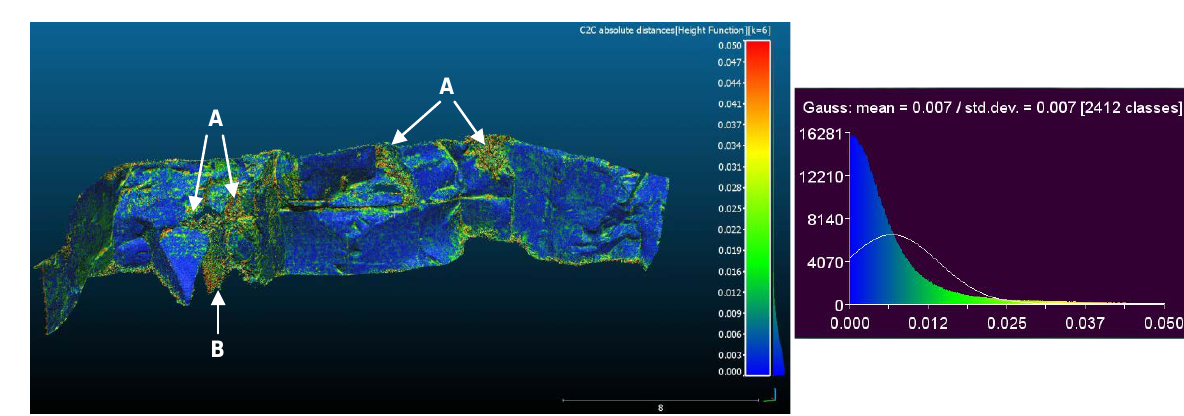
Figure 8. Error mapping of deviation between TLS and Panasonic Lumix